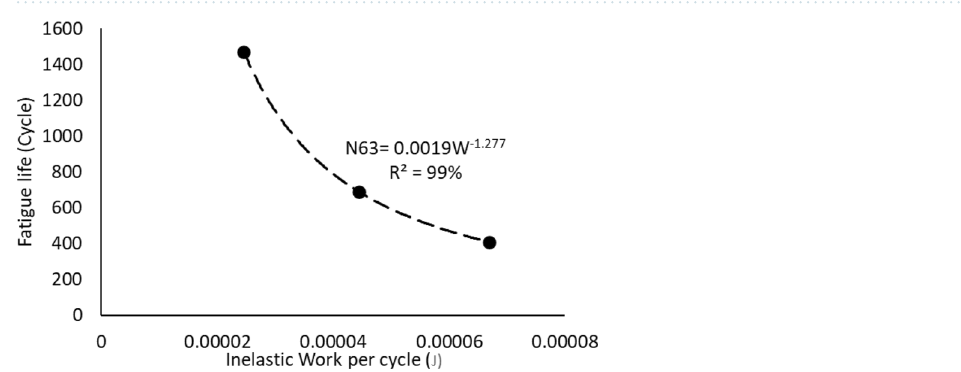
Figure 11. The evolutions in the hysteresis loop at different testing temperatures and stress amplitudes.